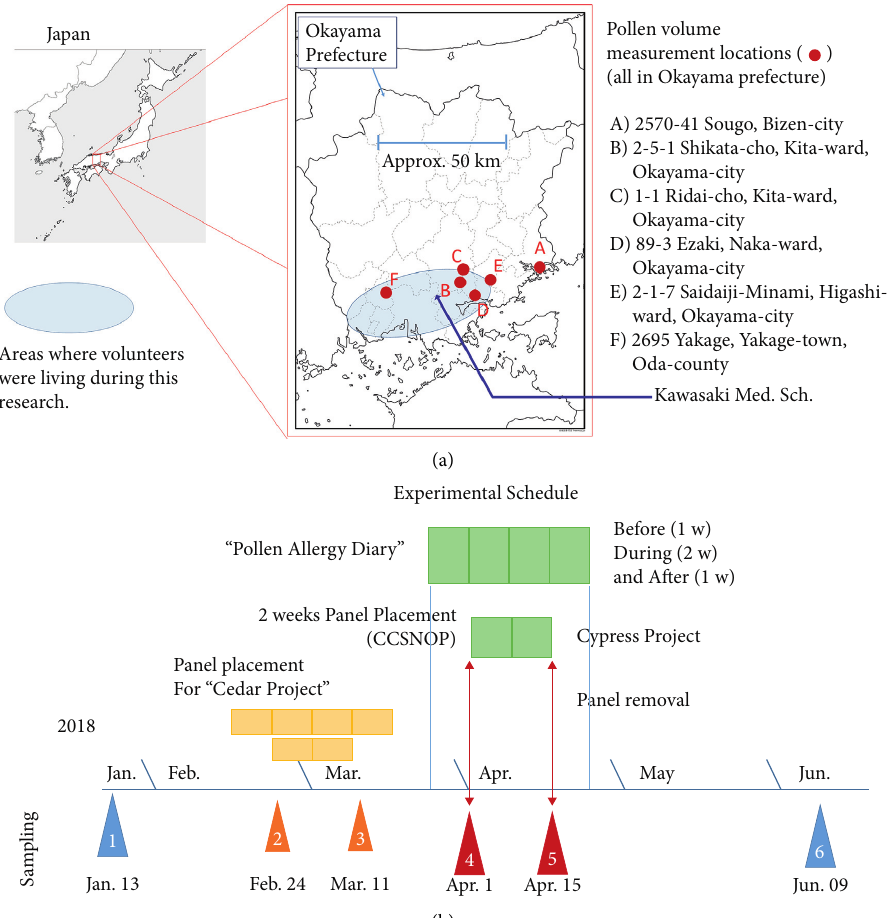
Figure 1: Areas where volunteers resided, measuring spots of cypress pollen (according to the literature shown in Figure 2), and ex- perimental schedule. (a) All subjects were residing in the southern part of Okayama Prefecture, Japan. Okayama Prefecture is located in the western part of Japan. A determination of the amount of cypress pollen at the dates when subjects were exposed to CCSNOP was obtained by inspecting the literature referred to in Figure 3. From this literature, A to F spots represent areas where cypress pollen volume was measured. The location (addresses) of the spots is shown. All spots except A overlapped with areas where subjects were residing. (b) The experimental schedule is shown. This study was based on a previous investigation that examined the effects of CCSNOP on 31 patients with Japanese cedar pollen allergies (“Cedar Project”). The results have been previously published. Ten subjects were then selected from the aforementioned 31 patients, all of whom were residing in the southern part of Okayama Prefecture, as shown in panel (a). For the “Cedar Project,” all subjects were exposed to CCSNOP in their bedrooms from February 24 to March 10, 2018. Each subject recorded a “Symptom Diary” from one week before CCSNOP was installed to one week after panel removal. Since the “Cedar Project” was performed as a double-blind study, subjects did not know whether they were exposed to CCSNOP or the control panel. However, in this “Cypress Project,” all subjects were exposed to CCSNOP, since the number of subjects was limited. For the “Cedar Project,” subjects were examined for mood (using POMS2), stress (measured by salivary amylase), blood collections for blood counts, and general screening such as liver and kidney function, lipids, minerals, and immunoglobulins G, A, and M condition on January 13, February 24, March 11, and June 9, 2018. Additionally, 29 specific cytokines were measured using serum derived from the blood collections. For the “Cypress Project,” CCSNOP exposure was from April 1 to 15, 2018. Subjects recorded a “Symptom Diary” for 4 weeks as with the “Cedar Project.” Additionally, the same examinations were performed before and after CCSNOP